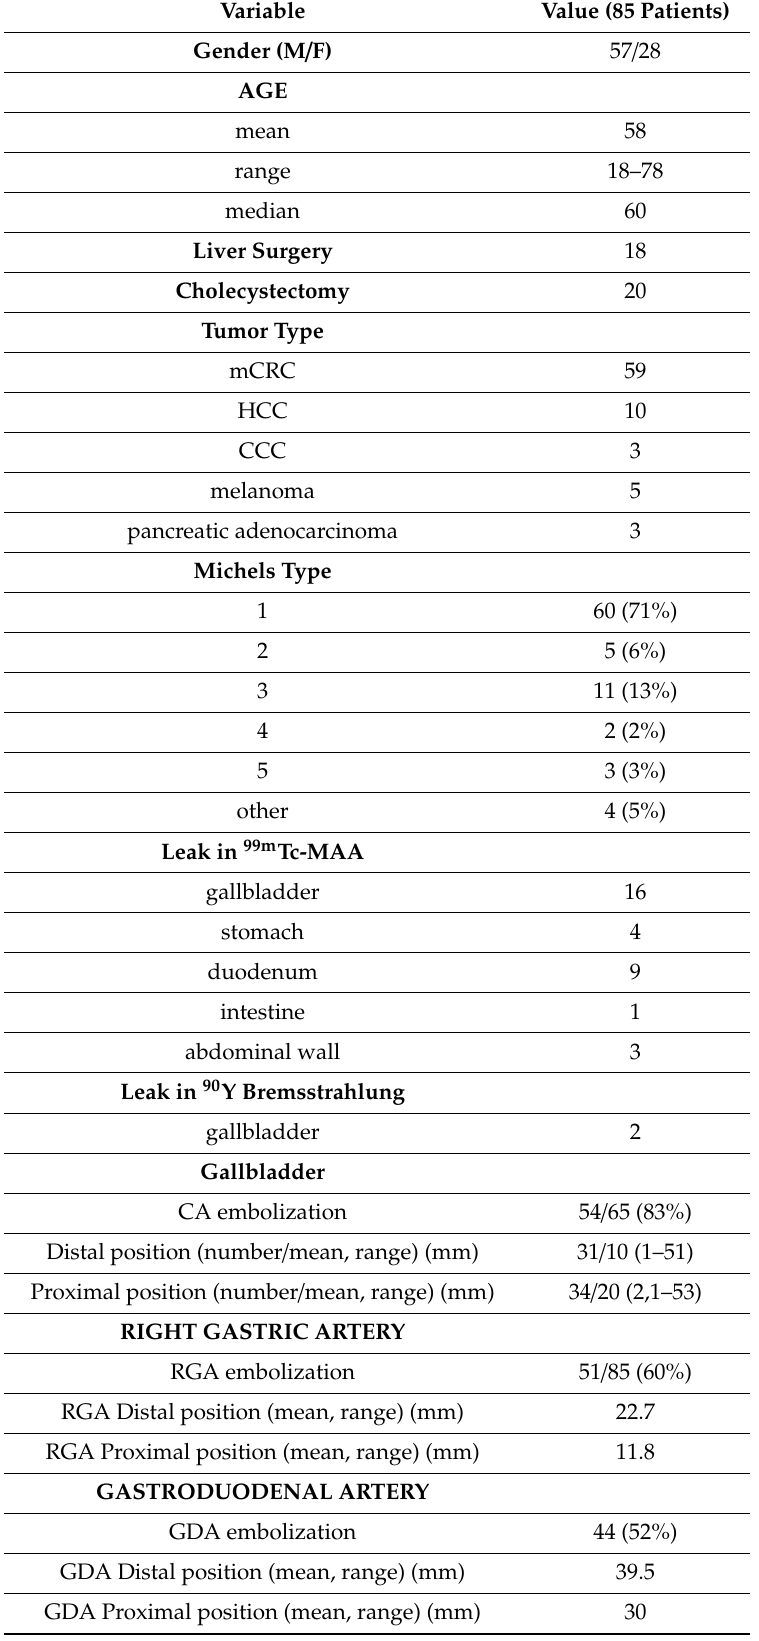
Table 1. Data summary for patient’s demographics, anatomy, tumor type, extrahepatic leaks, and measured